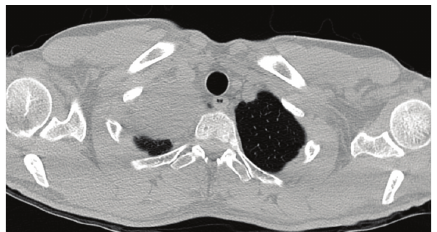
Figure 1: CT scan (CT) (axial view) showing a well-circumscribed, encapsulated ovoid mass, measuring approximately 5 cm, located in proximity to the right thoracic outlet.